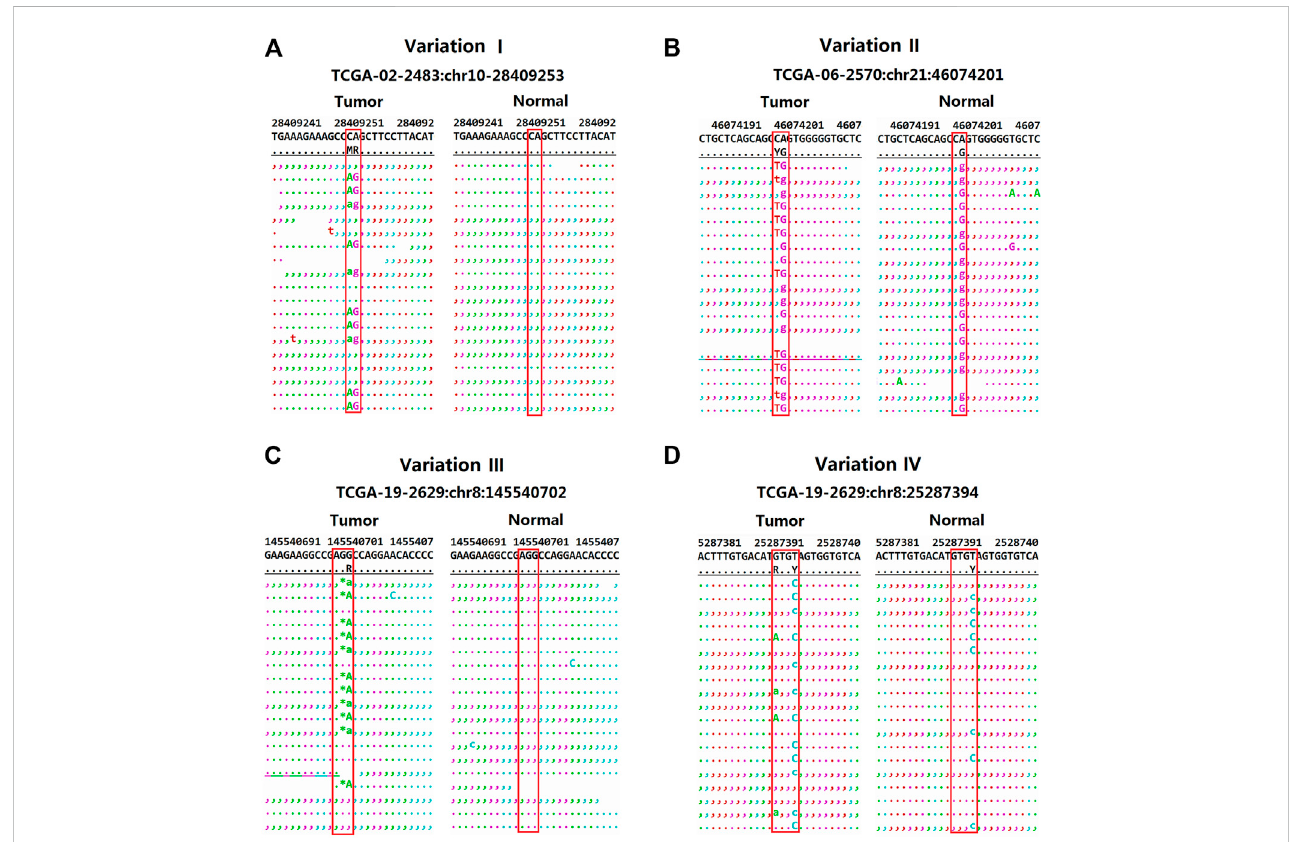
FIGURE 3 ThedistributionofreadsforfourvariantsintheTCGAsample(obtainedbysamtoolstviewprogram). (A) ThedistributionofreadsforCA- > AGintheTCGA sample. (B) ThedistributionofreadsforC- > TintheTCGAsample. (C) ThedistributionofreadsforGC- > AintheTCGAsample. (D) Thedistributionofreadsfor G- > A in the TCGA sample.